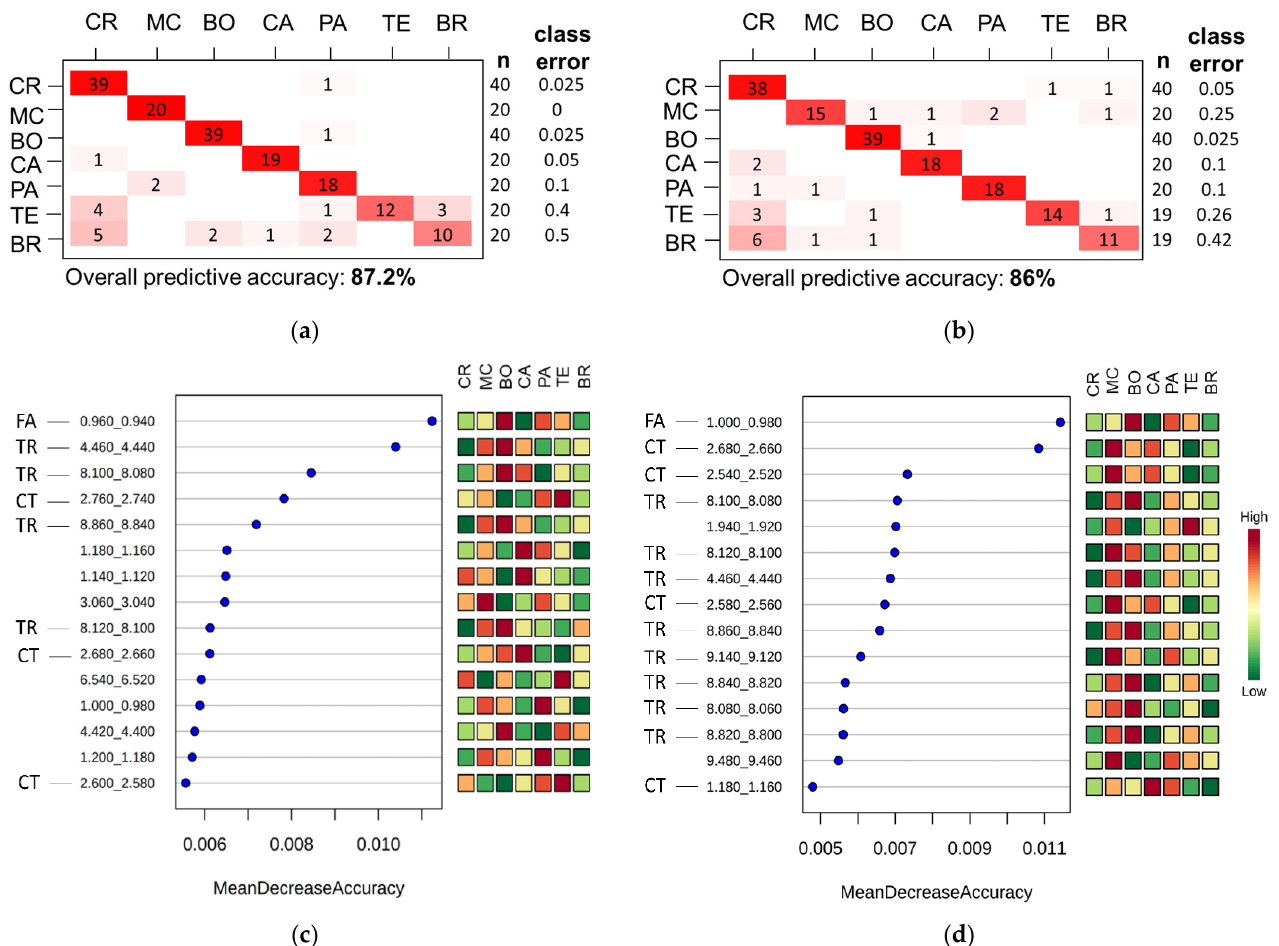
Figure 2. Variety fingerprint assessment through RF. Confusion matrices of RF algorithm of green ( a ) and roasted ( b ) coffee bean spectra. A summary of the variable importance measures for the buckets of coffee NMR spectra with variety as the response variable in the RF model is reported: ( c ) for green coffee model ( a , d ) for roasted coffee model ( b ). Buckets are ranked according to the mean decrease in classification accuracy when they are permuted. Calculated RF class error and mean decrease accuracy units can be also read as percentage (e.g., class error of 0.05, means 5%). Most important buckets regions corresponding to assignable resonance present both in green and roasted coffee RF models ( c , d ) are labeled accordingly: fatty acid, FA; trigonelline, TR; citric acid, CT. Corresponding RF score plots are reported in Supplementary Materials Figure S3.